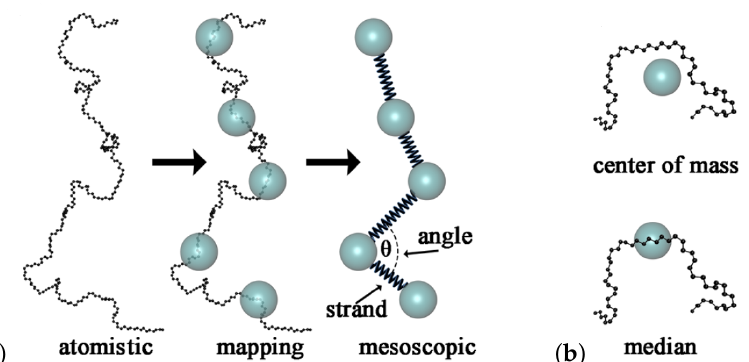
Figure 14. From the atomistic to the mesoscopic representation. ( a ) Mapping of a real polymer chain with 260 carbon atoms onto a sequence of five coarse-grained beads ( N = 52). ( b ) Two approaches for mapping atomistic polymer segments onto beads. A bead can be assigned either to the center of mass of a segment or to the coordinates of the central atom(s) of a segment. Reprinted from [204] with permission from